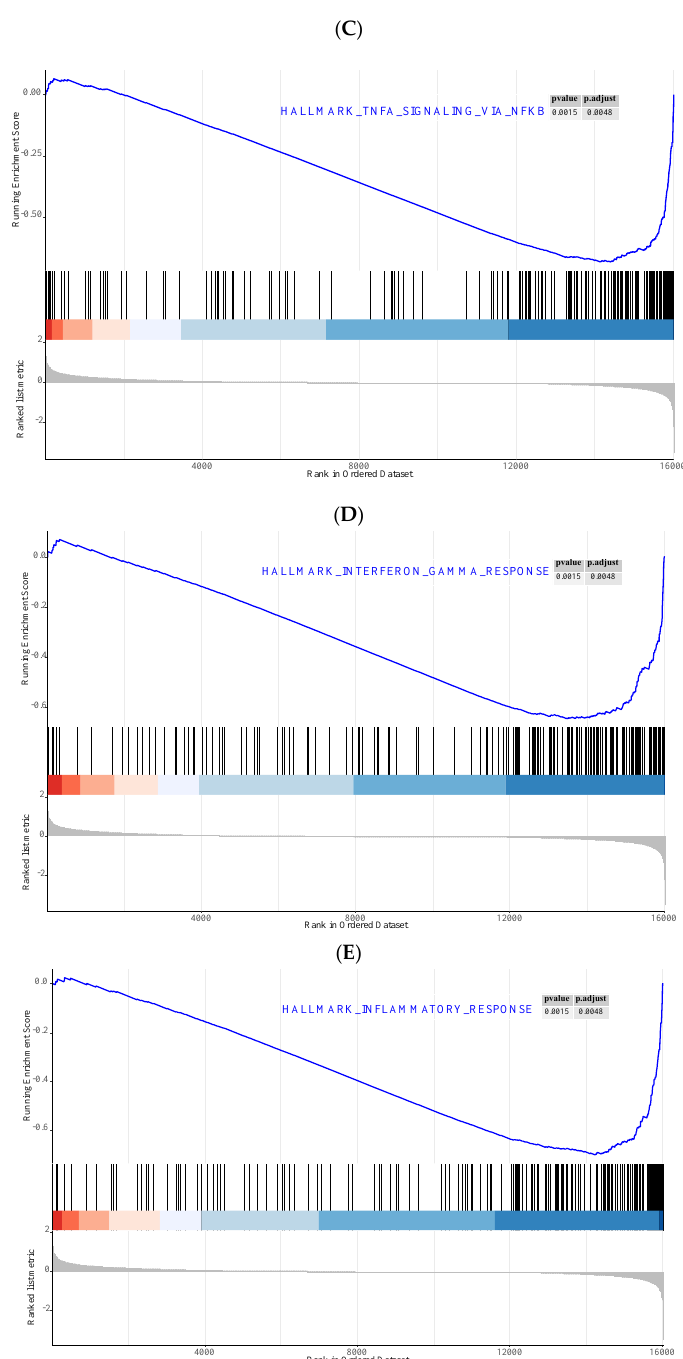
Figure 6. Results of GSEA in HCM of GSE36961 database. ( A ) Enrichment plots of HCM. The color intensity of the nodes represents the enrichment degree of pathways. The horizontal axis is gene ratio representing the proportion of differential genes in the whole gene set. The dot size represents the gene counts in a certain pathway. Oxidative phosphorylation pathway ranked first among the activated pathways, while tumor necrosis factor alpha-nuclear factor- κ B (TNF α -NF κ B), interferon- gamma (IFN γ ) response, and inflammatory response ranked the top three among the suppressed pathways. ( B ) Enrichment plot of genes involved in oxidative phosphorylation. ( C ) Enrichment plot of genes involved in TNF α -NF κ B. ( D ) Enrichment plot of genes involved in IFN γ response. ( E ) Enrichment plot of genes involved in inflammatory